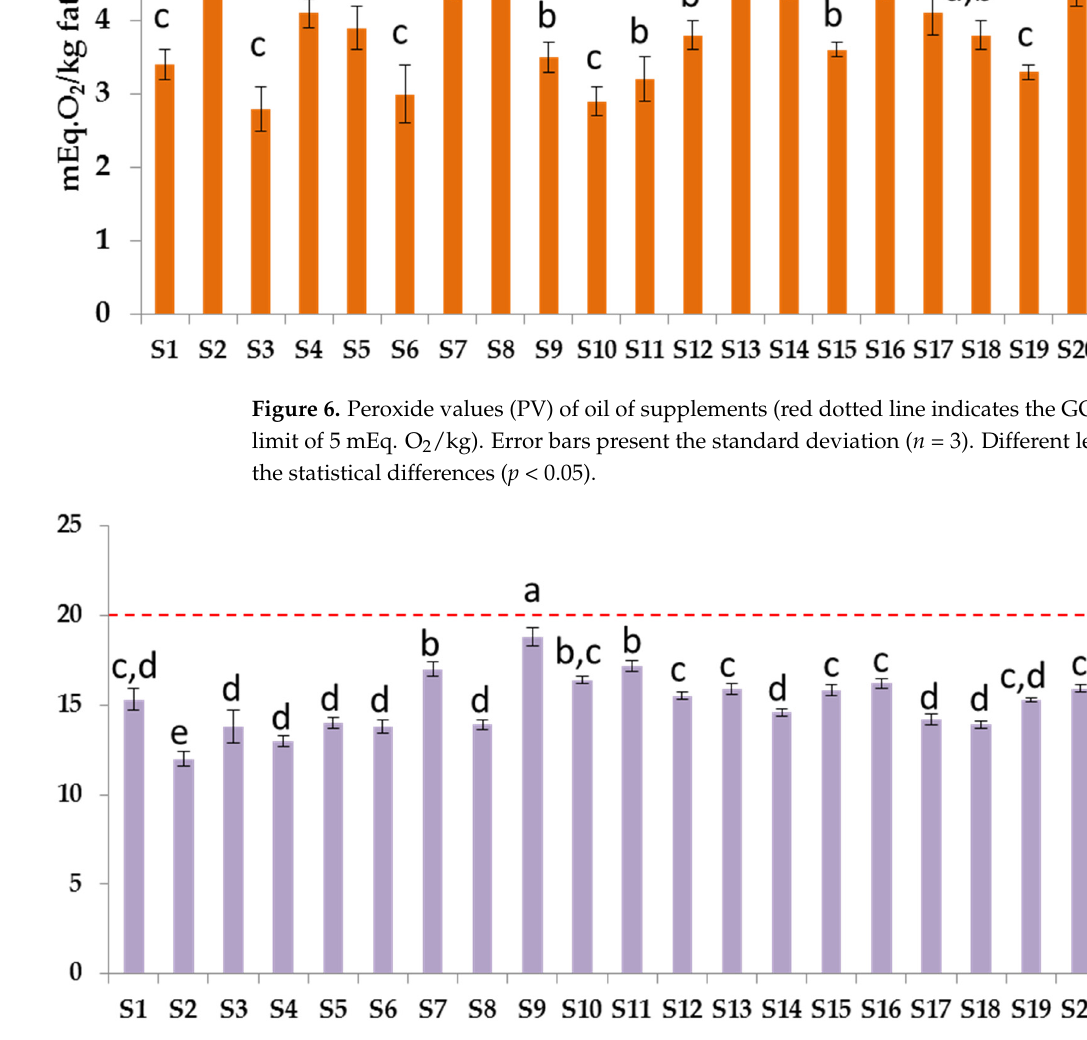
Figure 6. Peroxide values (PV) of oil of supplements (red dotted line indicates the GOED maximum limit of 5 mEq. O 2 /kg). Error bars present the standard deviation ( n = 3). Different letters report on the statistical differences ( p < 0.05).